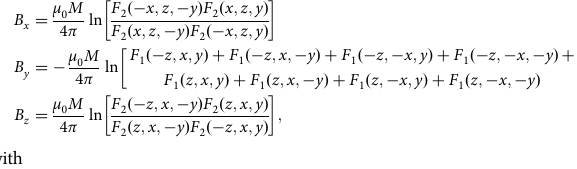
Fabrication of freestanding ultrathin elastomeric membrane . Preparation of a freestanding elastomeric membrane began with mixing soft silicone elastomer (Eco fl ex 00 — 20, Smooth-On) with silicone thinner (Silicone Thinner, Smooth-On) at a 10:8 weight ratio (silicone: thinner). A thin layer of polyvinyl alcohol (PVA) solution (20 wt%) was spin coated (3000 rpm for 30s) and cured (110°C on a hotplate for 1min) on a clean glass slide (75 mm ×50 mm) serving as a sacri fi cial layer. The diluted silicone mixture was then spin cast (6000rpm for 30 s) onto the PVA layer and cured (75 °C in an oven for 30min), to yield a thin elastomeric membrane (thickness = ~5 µm). A 3D printed frame (thickness = 8mm, printer: Form 3, Formlabs, material: Flexible 80A) was bonded onto this membrane using a silicone adhesive (Kwik-Sil, World Precision Instruments). Immersing the entire assembly in water overnight dissolved the underlying PVA, to release the mem- brane from the glass side with the frame to facilitate handling.